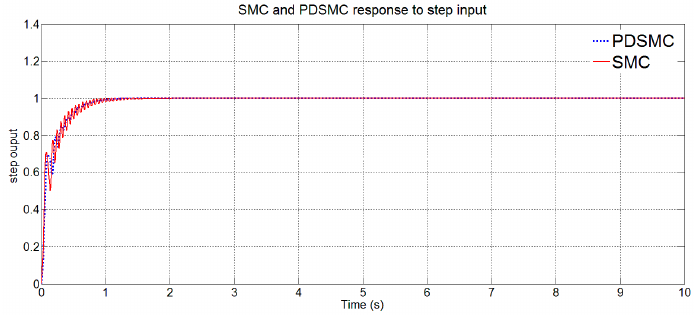
Figure 6. Sliding mode control (SMC) and proportional derivative sliding mode control (PDSMC) output response against step